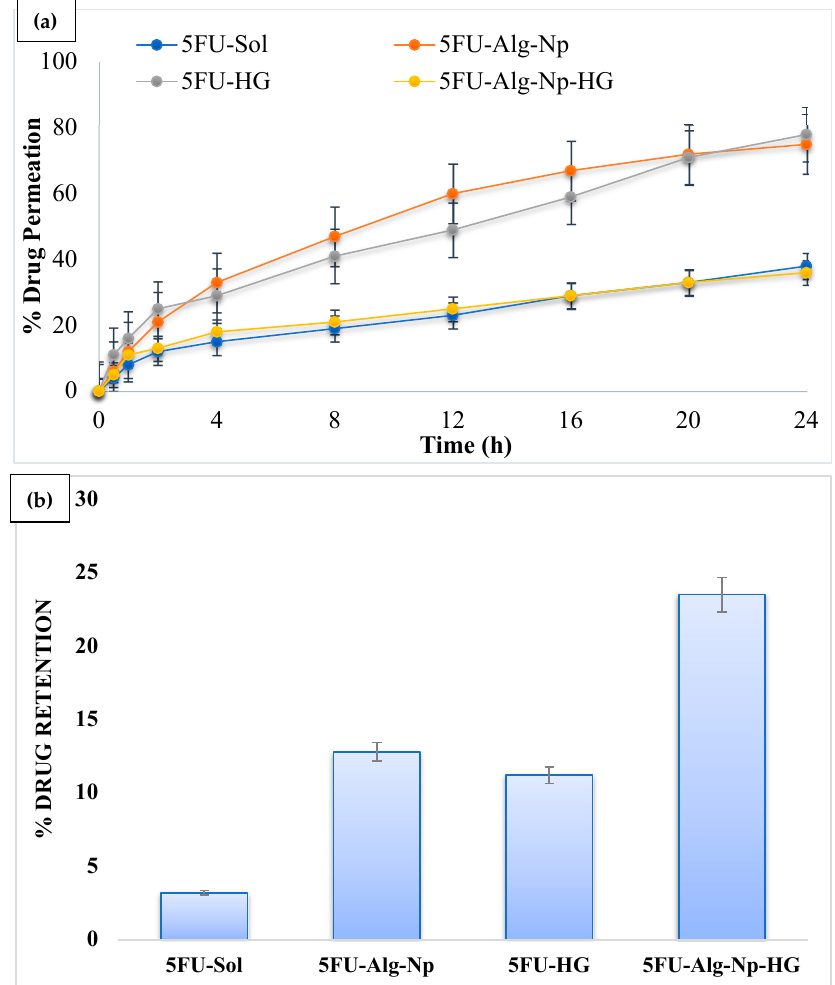
Figure 7. ( a ) Permeation profile and ( b ) skin-related drug retention of 5FU.